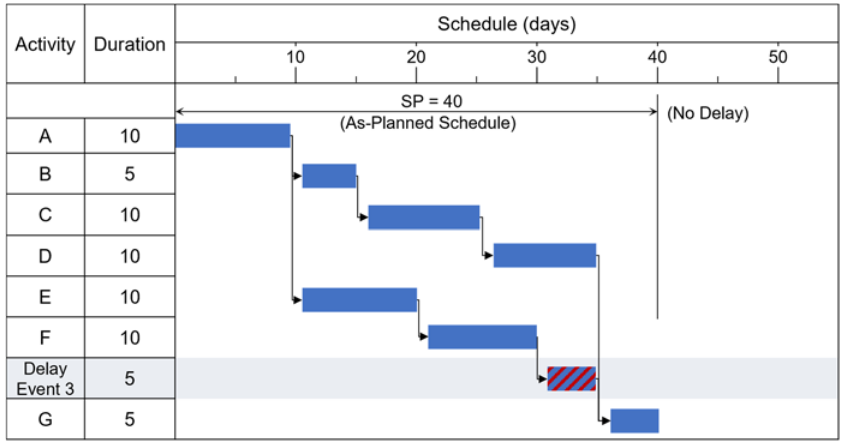
Figure 5. Impacted as-planned schedule by delay event 3 (owner-caused delay).